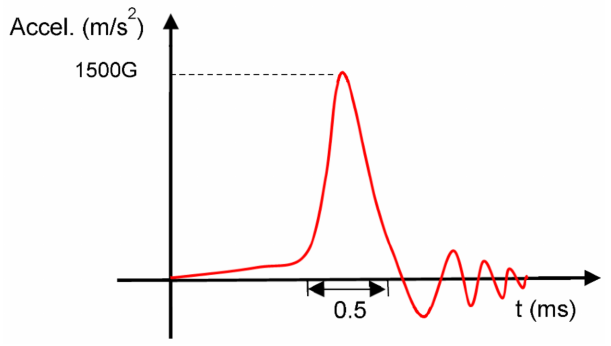
Figure 2. Impact acceleration of test